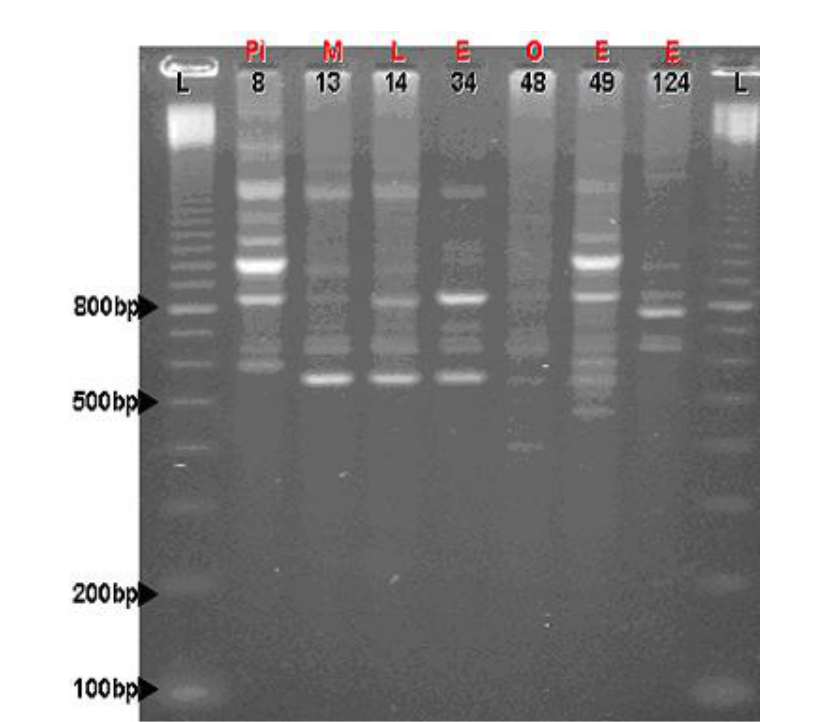
Figure 4. Gel electrophoresis and dendrogram of the RAPD profiles obtained from Klebsiella pneumoniae isolates with primer Operon